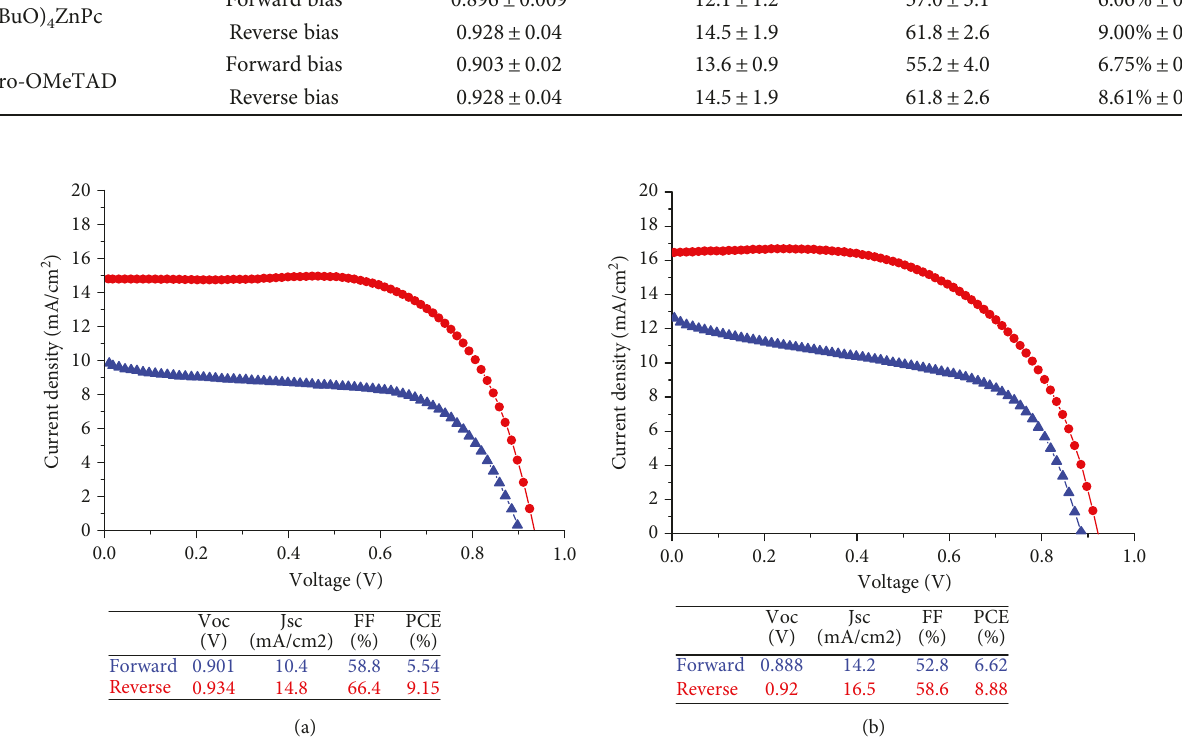
Figure 5: J-V characteristics of (a) ( n -BuO)